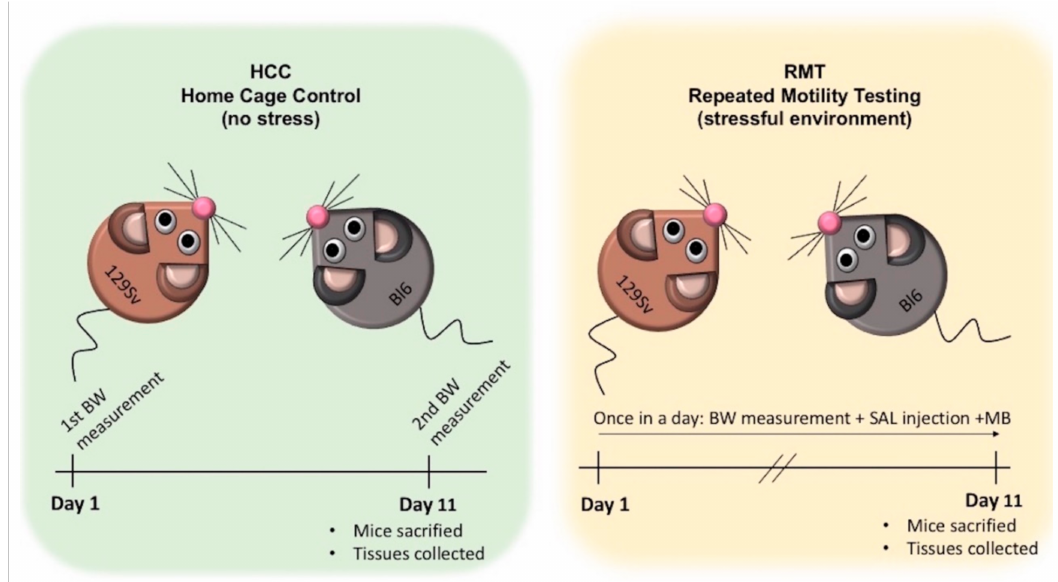
Figure 2. Schematic overview of the experimental design for gene expression measurement. Two batches of male 129Sv and Bl6 mice were used in this study. One batch (Bl6; n = 12 and 129Sv; n = 12) was used as home cage controls (HCCs). The other batch (Bl6; n = 16 and 129Sv; n = 14) was subjected to repeated motility testing (RMT batch). HCCs were weighed twice: on the 1st day and on the 11th day. In the RMT batch, on test days 1–11 the following routine was used: animals were weighed (BW measurement), 0.9% saline (SAL) solution was administered i.p. (SAL injection) and animals were placed for 30 min into single housing. After 30 min of single housing, animals were placed into the sound-proof motility boxes (MB) for 30 min for locomotor activity measurement and then returned to